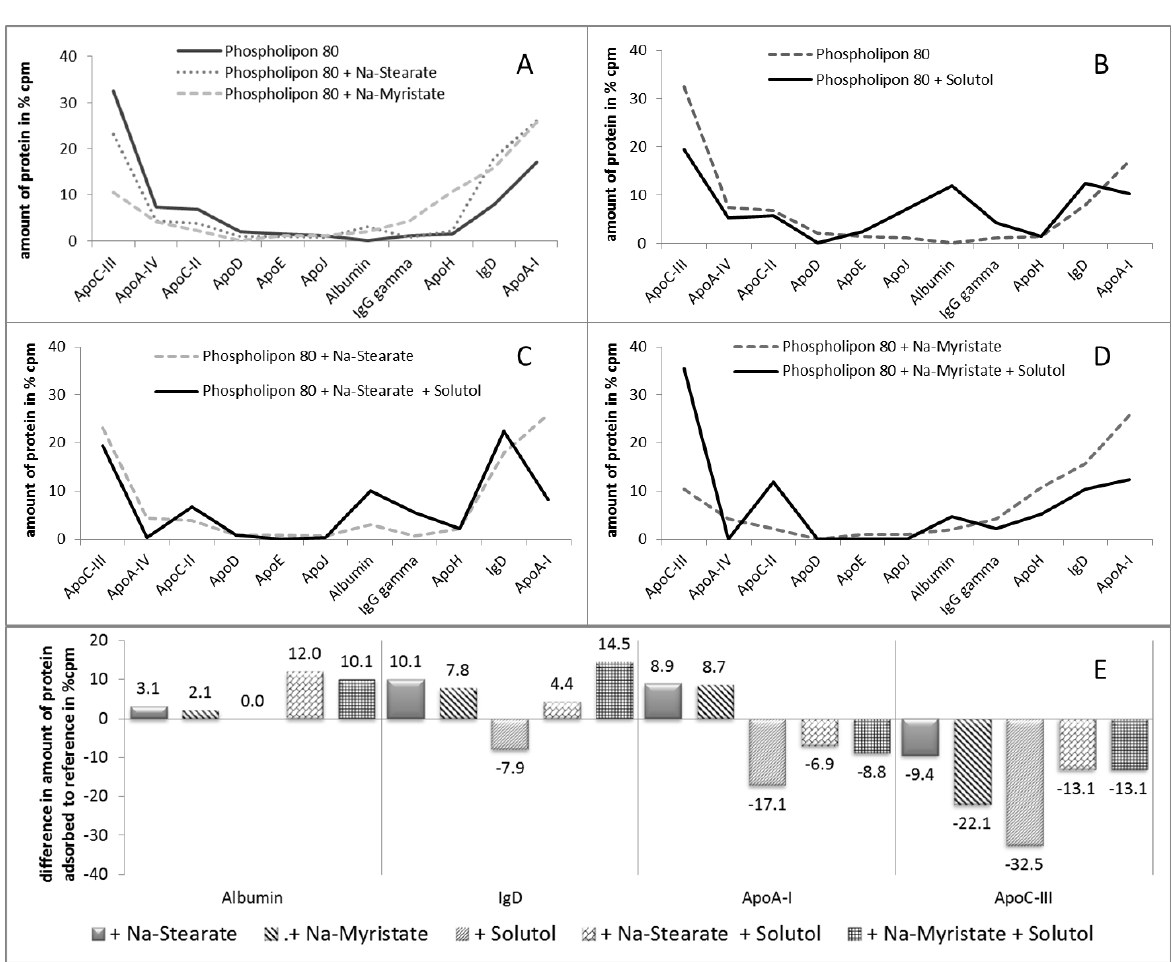
Figure 4. Type and amount of adsorbed plasma proteins on oil-in-water emulsions with different compositions of stabilizing agents. ( A ) Influence of the fatty acids sodium stearate and myristate in the composition of a Phospholipon 80 stabilized emulsion on the adsorption pattern; ( B – D ) Influence of sodium stearate and myristate in the composition of a Phospholipon 80/Solutol stabilized emulsion on the adsorption pattern (modified after [110]); ( E ) Difference of amount of adsorbed proteins due to different stabilizer composition compared to the standard stabilized with Phospholipon